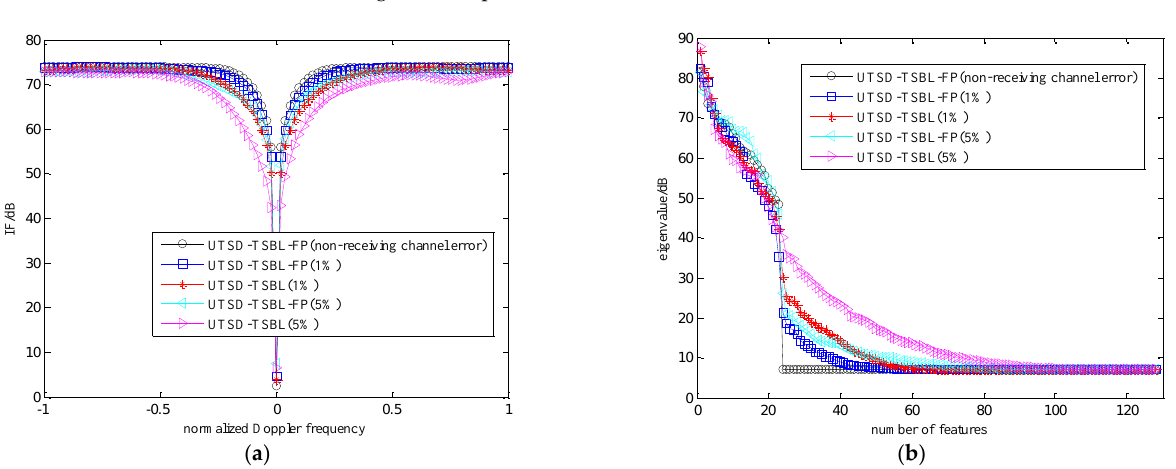
Figure 13. Performance comparison of two algorithms with clutter floating error: ( a ) improved factor; ( b ) clutter eigenvalue spectrum.